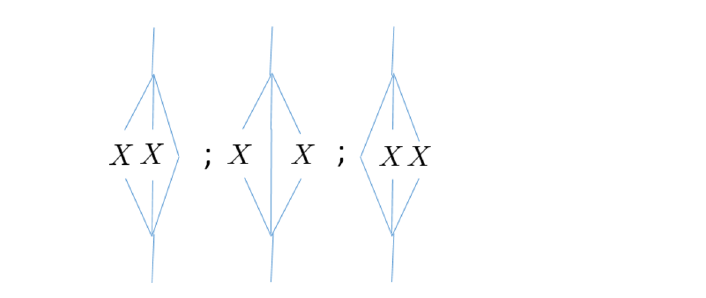
Figure 53. Each cross term contains contributions like one of the above three in a tensor product.